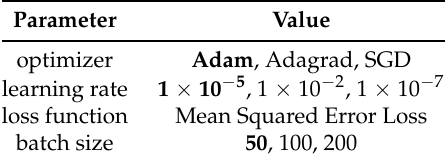
Table 2. Parameters used to configure the neural network of Figure 5: optimizer, learning rate, loss function, and batch size. The optimal settings are the ones highlighted in